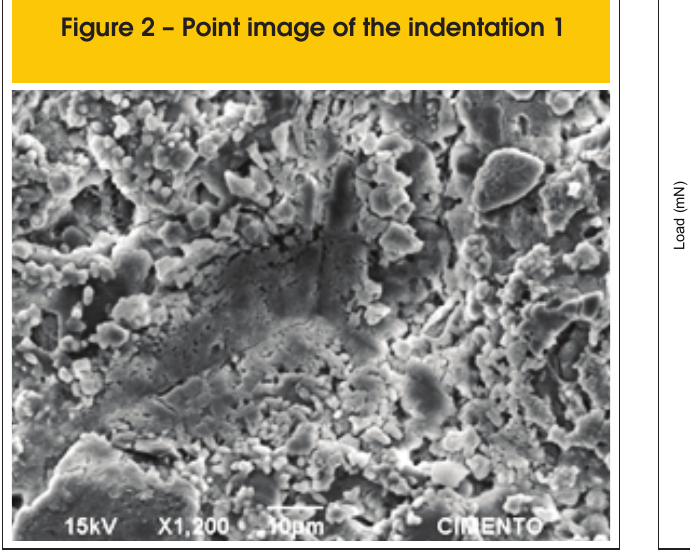
Figure 2 – Point image of the indentation 1